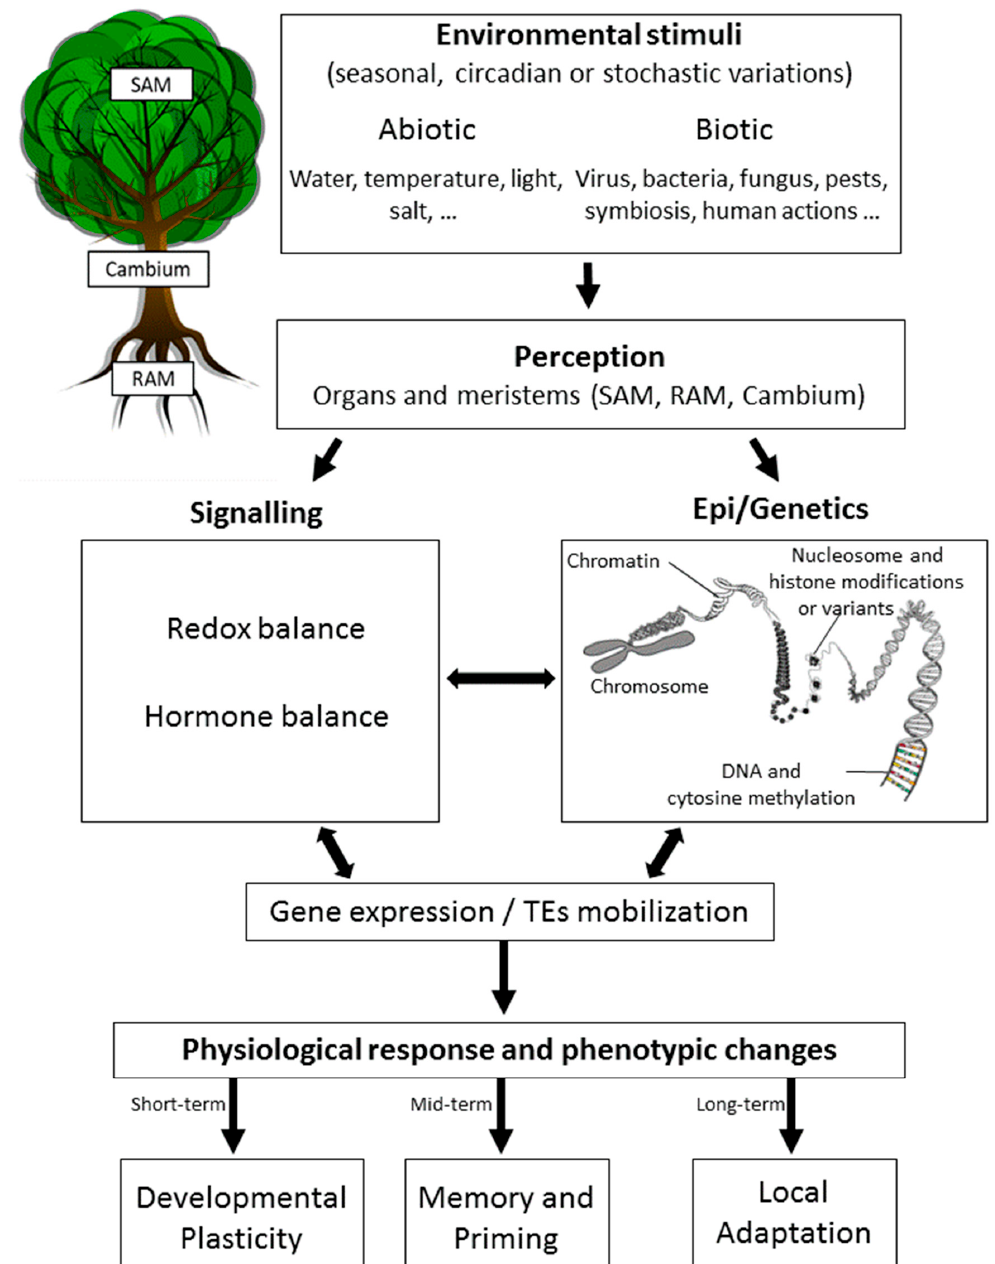
Figure 1. Epigenetic response to environmental changes in trees. Trees are known to recognize various abiotic and / or biotic stimuli occurring rhythmically (circadian or seasonal) or stochastically. These changes are perceived at di ff erent tissue levels, with most studies focusing on the leaves, roots, and meristems (SAM, shoot apical meristem; Cambium; or RAM, root apical meristem). Perception is then followed by signaling mechanisms that may include changes in the redox or hormonal balance, which have been shown to be related to epigenetic changes (chromatin remodeling, DNA methylation, non-coding RNA mechanisms (not shown), and histone modifications and variants). This complex crosstalk between signaling processes, epigenetics, and genetics results in an altered gene expression status and / or the mobilization of transposable elements (TEs). A physiological response is then observed together with phenotypic changes that allow trees to acclimate to the environmental changes initially sensed depending on the time-scale considered and the heritable transmission of epigenetic